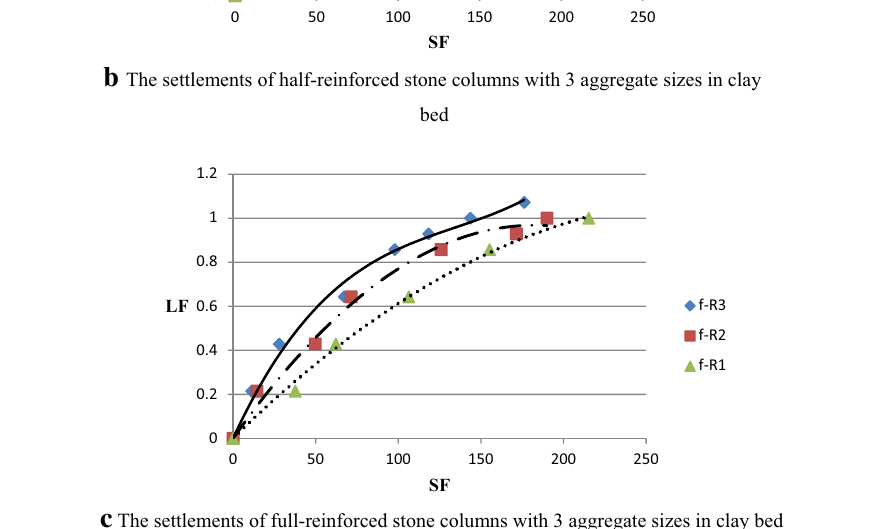
Fig. 7 Test results in clay bed for 3 aggregates sizes with different encasement